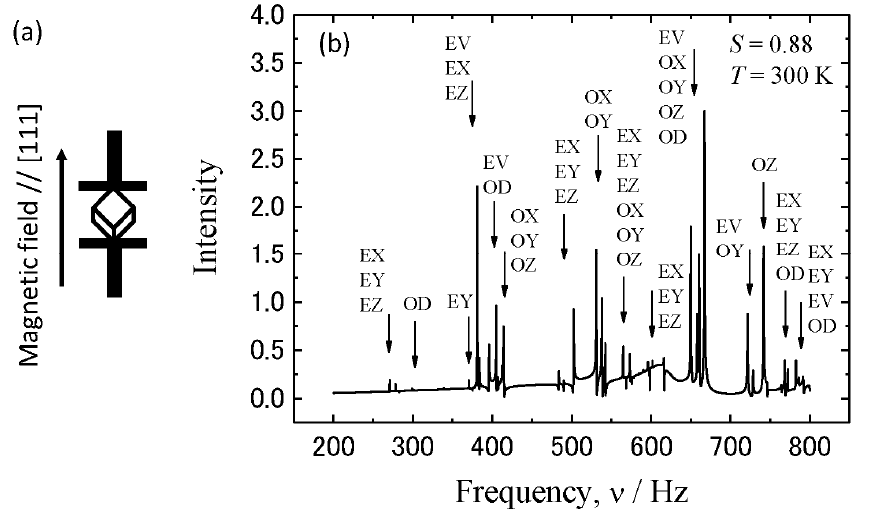
Figure 1. Schematic illustration showing the setting of the specimen for rectangular parallelepiped resonance (RPR) measurements under a magnetic field ( a ), and an example of the spectra of S88 at 300 K ( b ).